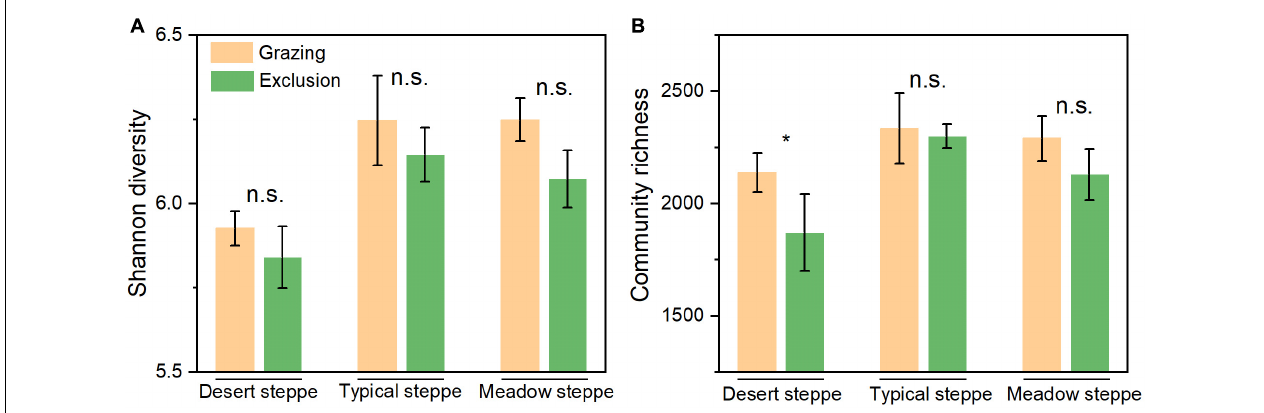
FIGURE 2 | The bacterial α -diversity (A) based on Shannon index and community richness (B) based on Sobs index between grazing and exclusion sites in three types of grasslands. Error bars indicate standard errors (3 replicate sites). “*” means significant difference ( P < 0.05) between grazing and exclusion sites. “n.s.” means non-significant.